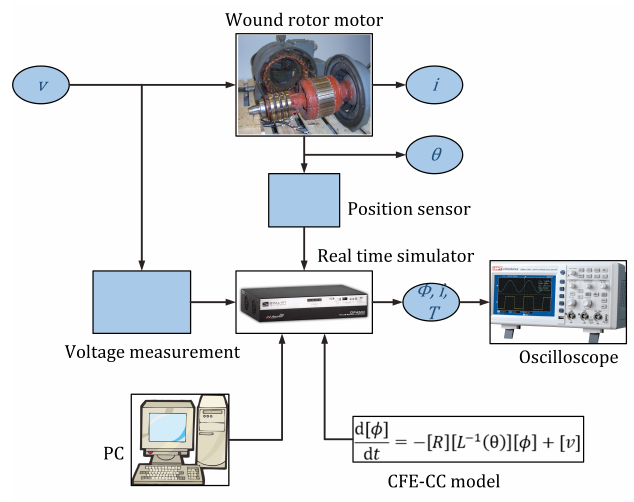
Figure 3. Hardware setup overview.